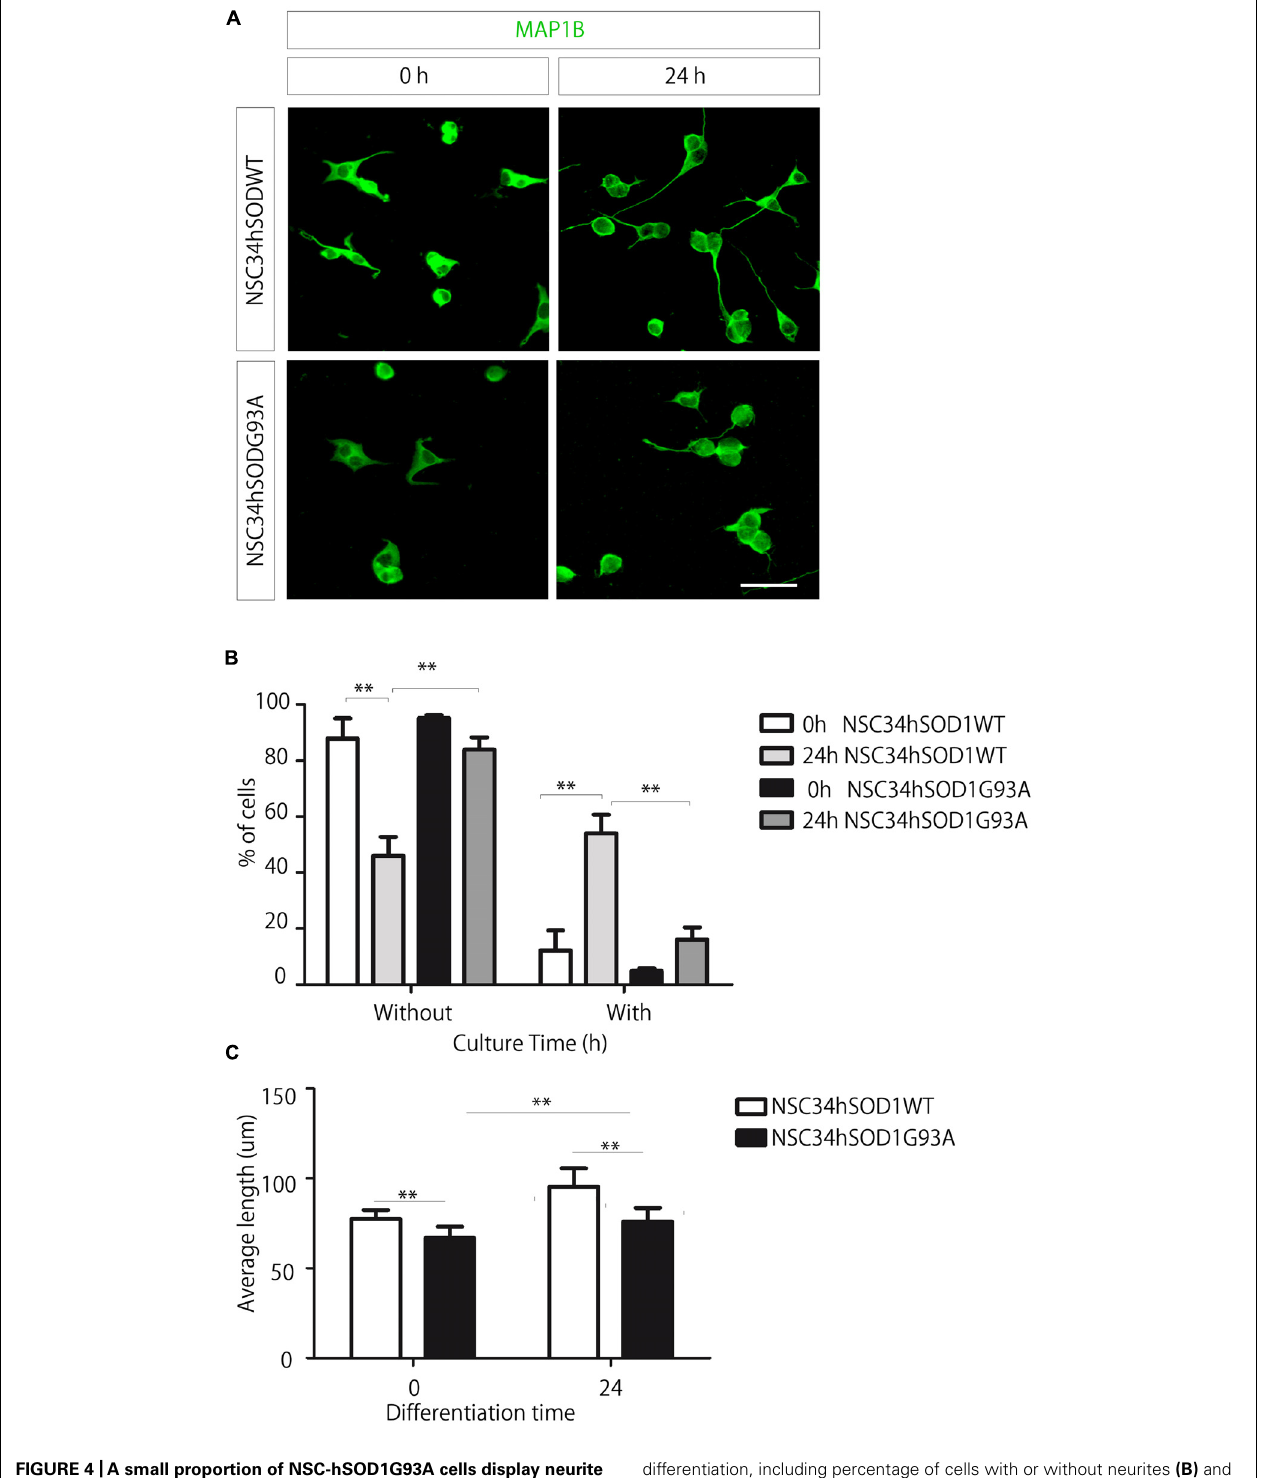
differentiation, including percentage of cells with or without neurites (B) and average neurite length (C) were measured using ImageJ. Plots are the average ± SEM of three independent experiments ( ∗∗ p < 0.01, ANOVA; ∗ p < 0.05, t test). Bar, 50 μ